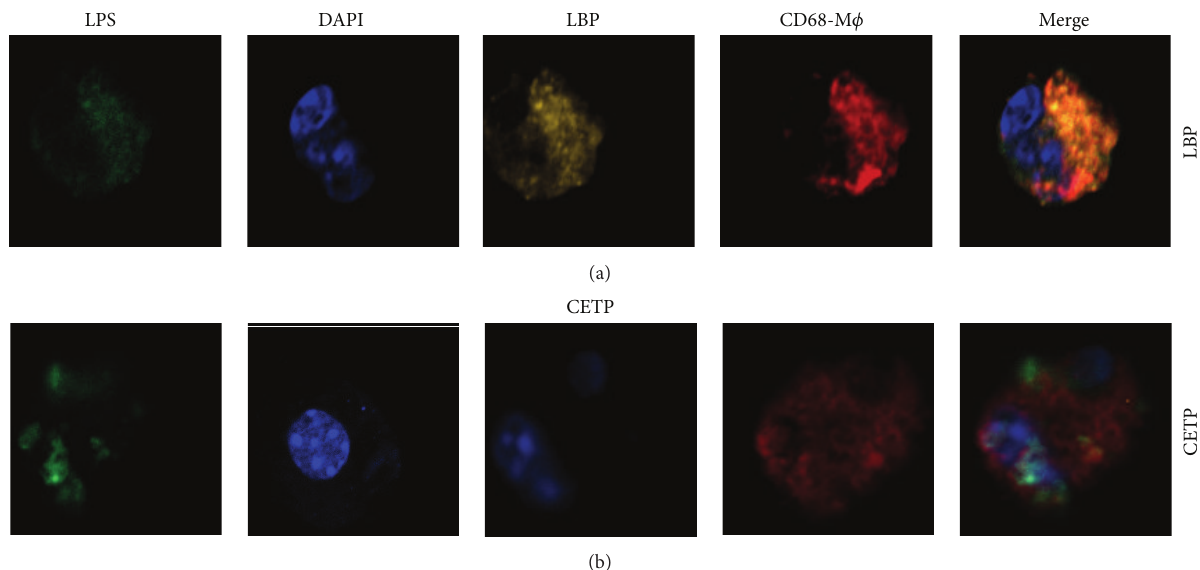
Figure 4: Confocal microscopy of macrophages: colocalization between LPS and CETP (magnification of 600x). Representative confocal imageofperitonealmacrophagesfromWTmicestimulatedwithLPS(1 𝜇 g/mL)for4 hinthepresenceoftheLBP,knowntobeattachedtoLPS: LBP was utilized as a positive control (a) or CETP (b) (1 𝜇 g/mL). FITC-LPS, green; nucleus, blue (DAPI); LBP, yellow; CD68 + macrophages, red; CETP, blue (in the absence of DAPI because CETP antibody is also blue); merge: colocalization between